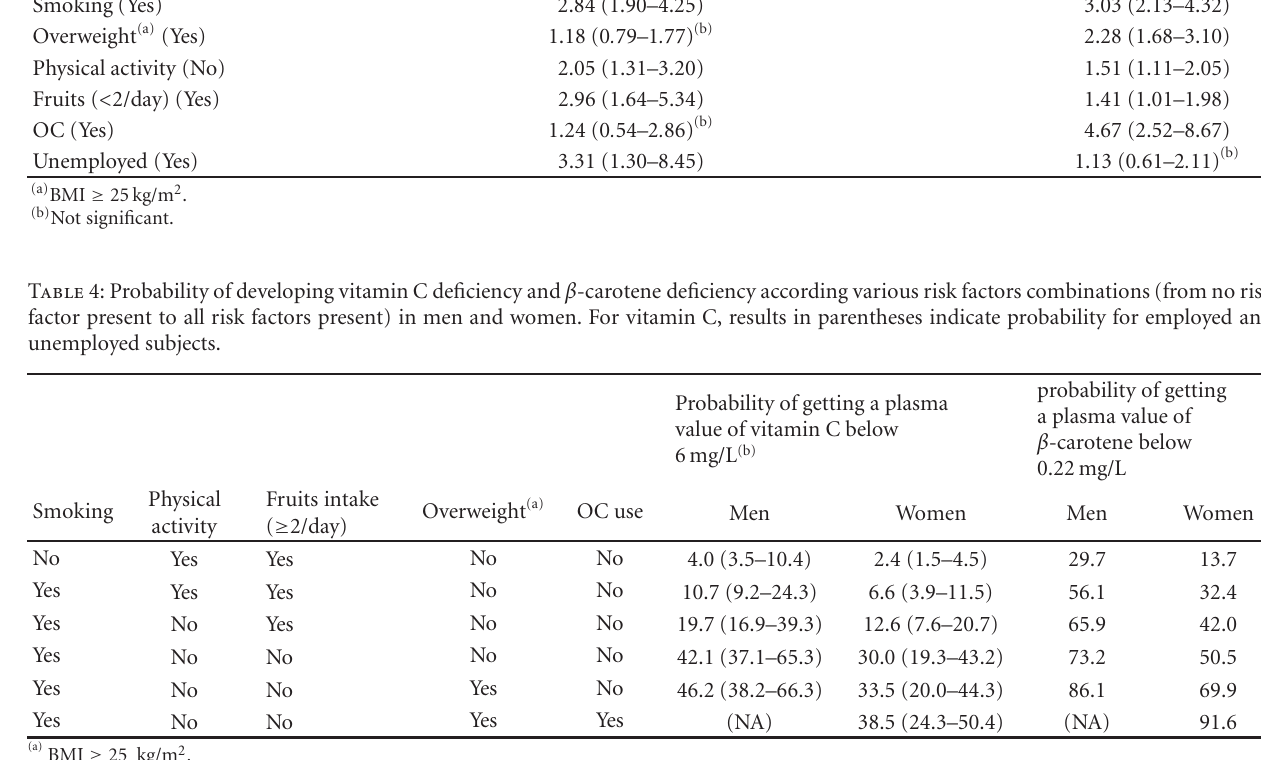
Numbers in parentheses indicated probability of vitamin C deficiency when subject being employed or